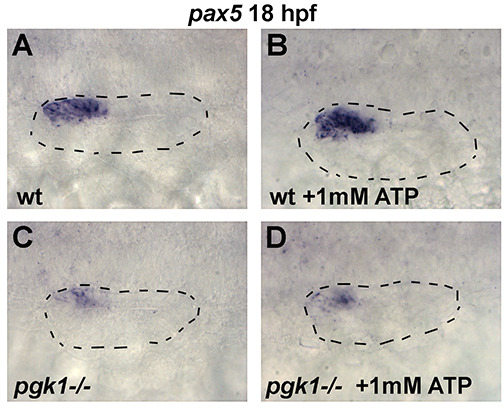
Exogenous ATP does not rescue pgk1- / - mutants.Dorsolateral view (anterior to the left) of the otic vesicle (outlined) showing expression of etv5b (A–D) or pax5 (E–H) at 18 hpf in wild-type embryos or pgk1- / - mutants with or without exposure to exogenous 1 mM ATP. NS, no significant difference between groups indicated in brackets.